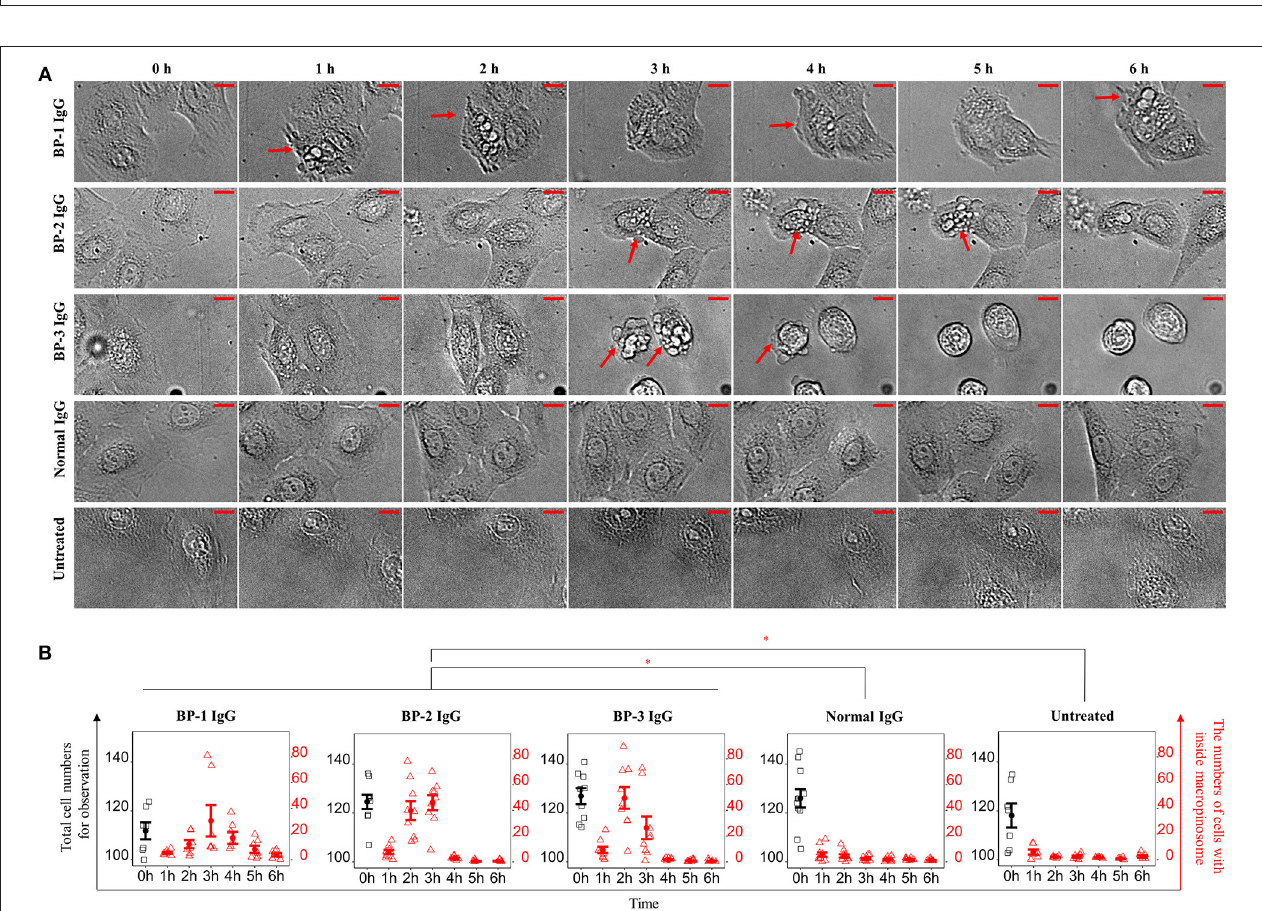
FIGURE 1 | ColXVII COOH IgG (ColXVII IgG, 12 µ g/ml) and then subsequently stained with FITC- or Alexa Fluor 488-conjugated secondary antibodies (green). The nucleus was stained with DAPI (blue). Scale bar 10 µ m. (B) Quantification of the fluorescence intensity of IgG bound to fixed NHEKs. Data were analyzed using ICY software. (C) Evaluation of the cell surface IgG binding using flow cytometry. NHEKs were cocultured with 2 mg/ml IgGs for the indicated times and then immediately fixed without permeabilization. The cells were directly incubated with anti-human IgG-FITC and were examined using flow cytometry. (D) Evaluation of the cell surface ColXVII expression using flow cytometry. NHEKs were cocultured with 2 mg/ml IgGs for the indicated times, and then immediately fixed without permeabilization. Then, cells were first incubated with an IgG specific for human ColXVII-COOH, and then incubated with Alexa Fluor 488-conjugated anti-IgG. Cells were examined using flow cytometry. (E) Fluorescence microscopy images of the binding of the indicated IgGs to NHEKs. NHEKs were incubated with BP IgGs (BP-1, BP-2, or BP-3, 2 mg/ml), normal IgG (2mg/ml), or ColXVII IgG (12 µ g/ml) for the indicated times. Then, the cells were fixed, permeabilized, subsequently stained with FITC- or Alexa